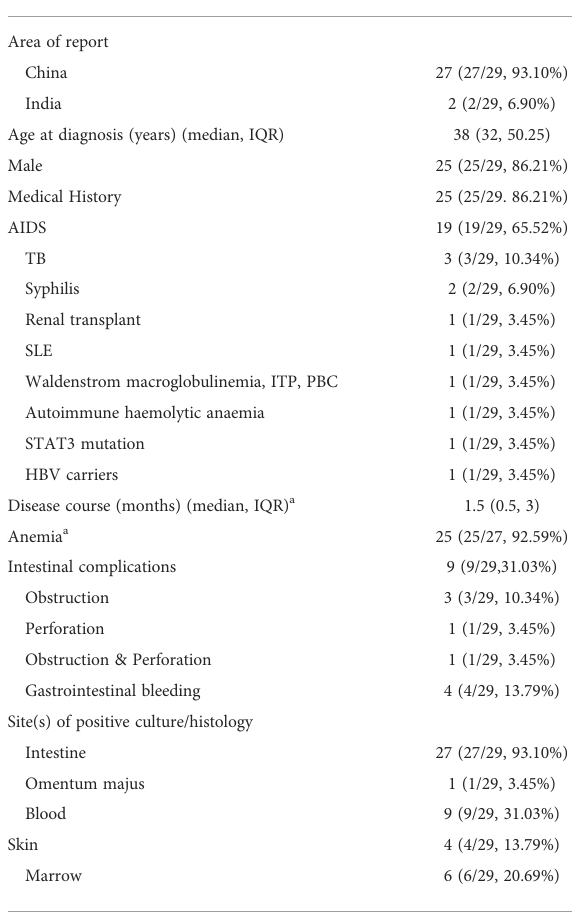
TABLE 1 Clinical Characteristics Concerning 29 Patients With Gastrointestinal